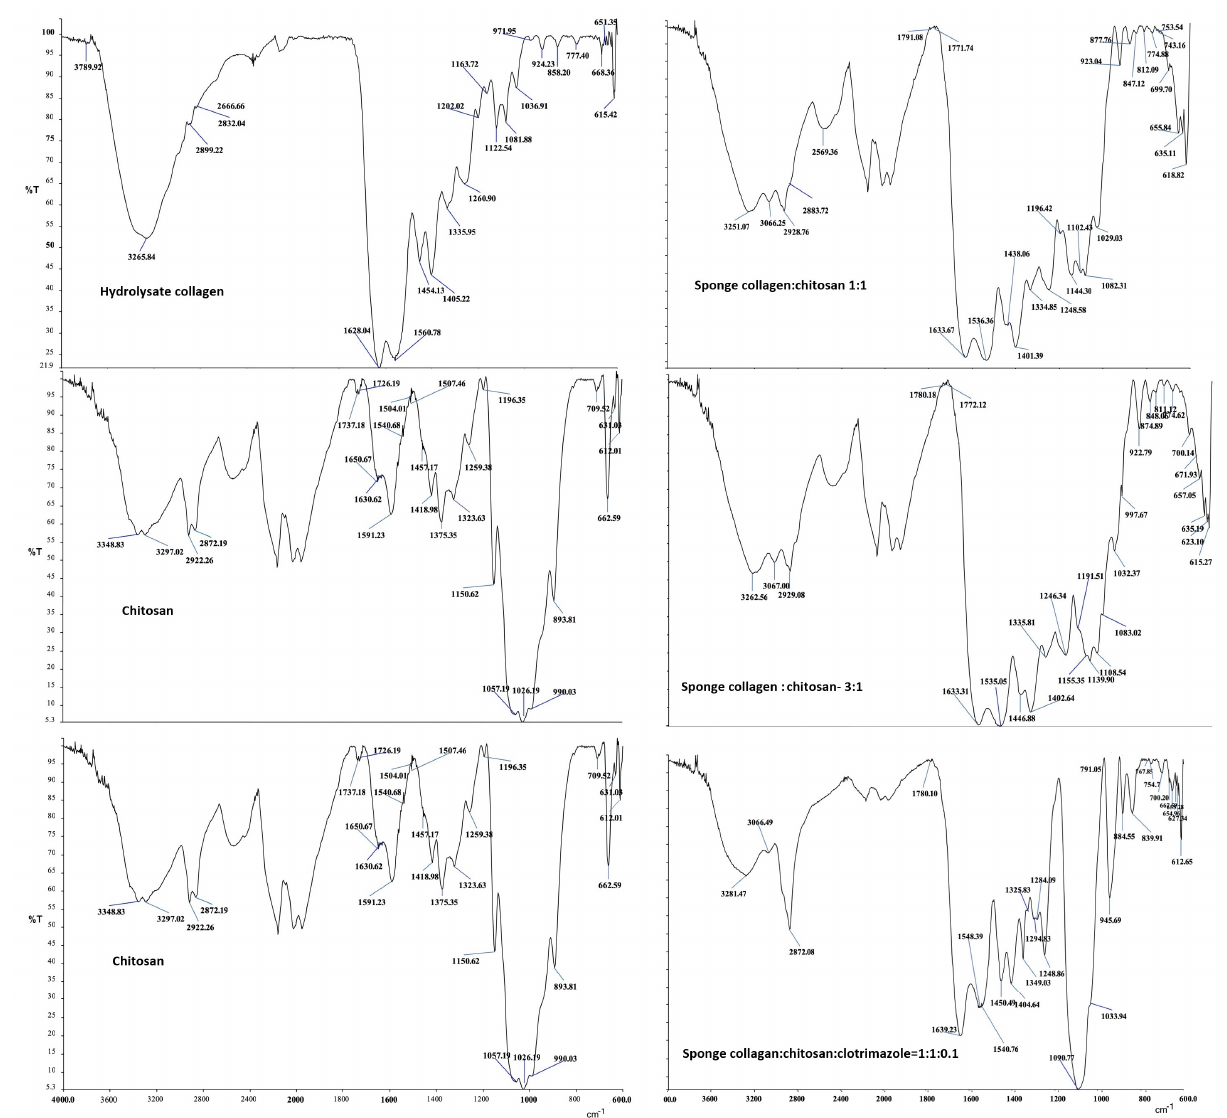
Figure 10. Infrared spectra of hydrolyzed collagen, chitosan, clotrimazole, and composite biomaterial with a collagen–chitosan mass ratio of 1:1; composite biomaterial with a collagen–chitosan mass ratio of 3:1; functionalized composite biomaterial with a collagen–chitosan –clotrimazole mass ratio of 1:1:0.1.